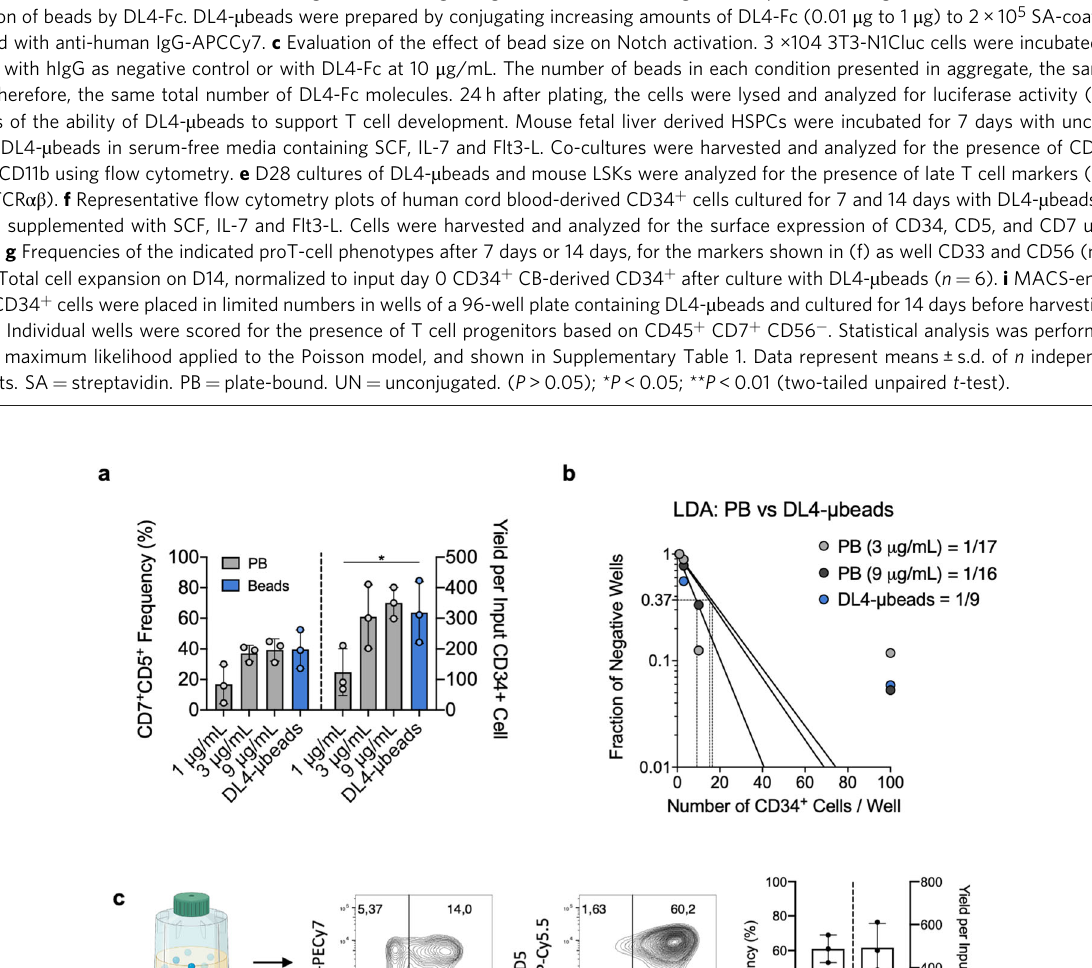
Fig. 2 Scalability and comparison of DL4- μ beads to plate-bound DL4-Fc cultures. a 1 × 10 3 CB-CD34 + cells were cultured with DL4- μ beads or on plate- bound DL4-Fc, as indicated, for 14 days and analyzed by fl ow cytometry for the expression of CD5 and CD7. Cell counts were normalized to input day 0 CB-derived CD34 + cells ( n = 3). b CB-CD34 + cells were placed in a limiting dilution assay for 14 days before scoring for the presence of CD45 + CD7 + CD56 − cells. Statistical analysis was performed via the method of maximum likelihood applied to the Poisson model. c DL4- μ beads were assessed for adaptability to G-Rex system. 2.5 × 10 4 CB-CD34 + cells were cultured with DL4- μ beads in a G-Rex 24-well plate format for 7 days, followed by a full- media change and re-addition of fresh DL4- μ beads for another 7 days. D14 cultures were harvested, counted and analyzed for the expression of CD34, CD7 and CD5, as indicated, from CD45 + -gated cells. Cell counts were normalized to input day 0 CB-derived CD34 + cells ( n = 3). PB = plate-bound. Data represent means± s.d. of n independent experiments. ( P > 0.05); * P < 0.05 (one-way ANOVA followed by Fisher ’ s Least Signi fi cant Difference). G-Rex image was created with BioRender.com (Toronto, Differentiation of human PSCs to T-lineage cells by DL4- population with T cell potential 23 . There is no apparent increase μ beads . Despite advances in the ability to differentiate human in cellularity from the iPSC to EB differentiation step, which PSCs into different hematopoietic lineages, the generation of given the percentage of CD34 + cells obtained from EBs post- T cells has been especially challenging, under serum- and MACS enrichment, resulted in an approximate cell yield of 1 stroma-free conditions. To address this, we induced the differ- iPSC-derived CD34 + cell per 10 iPSCs used to initiate the culture. entiation of human iPSCs as embryoid bodies (EBs) in chemi- Sorted (D8) iPSC-derived CD34 + cells (iPSC-CD34 + ) were cally de fi ned media with a stage-speci fi c combination of cultured with DL4-µbeads, and fl ow cytometric analysis of early morphogens and hematopoietic cytokines (Fig. 3a). After 8 days time points, day 7 and 14, showed the appearance of CD34 + CD7 + of differentiation, CD34 + cells were harvested and stained for the presence of markers that identify arterial (CD184 + ) and venous cells, followed by CD34 − CD7 + CD5 + cells (Fig. 3c,d). LDA (CD73 + ) endothelium (Fig. 3b). Cells lacking the expression of these two markers include a de fi nitive hemogenic endothelium